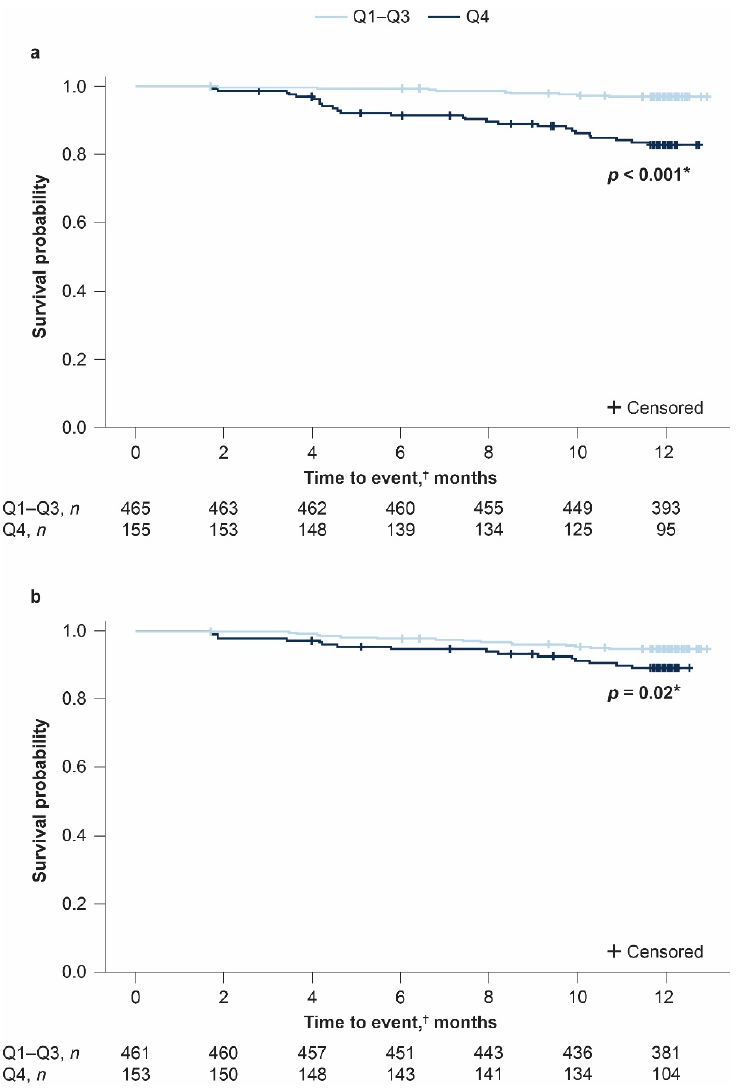
Figure 1. Kaplan–Meier plots of all-cause mortality based on quartiles as defined by ( a ) neutrophil–lymphocyte ratio (NLR) and ( b ) platelet–lymphocyte ratio (PLR) changes from baseline to Month 12 in patients with idiopathic pulmonary fibrosis (IPF) (pooled from the placebo groups of ASCEND and CAPACITY). * Log-rank test p- value. † Six patients had their Month 12 assessment at or after 12.5 months. Q: quartile. In the pirfenidone 2403 mg/day group, the median 12-month change in NLR by quar- tile was − 0.6, 0.1, 0.7 and 1.8 for Q1, Q2, Q3 and Q4, respectively. Significant trends were any respiratory hospitalization, and any respiratory hospitalization or death, but not for the other clinical outcomes assessed (Supplementary Materials Table S4). 3.5. Changes in PLR In the placebo group, the median 12-month change in PLR by quartile was − 35.7, − 6.1, 12.2 and 49.0 for Q1, Q2, Q3 and Q4 (as defined by the change from baseline to Month 12 in PLR), respectively (Supplementary Materials Table S5). Significant trends were ob- served across the PLR change quartiles for all outcomes, with patients with the greatest change in PLR (Q4) experiencing the worst outcomes. Similar declines in percent pre-